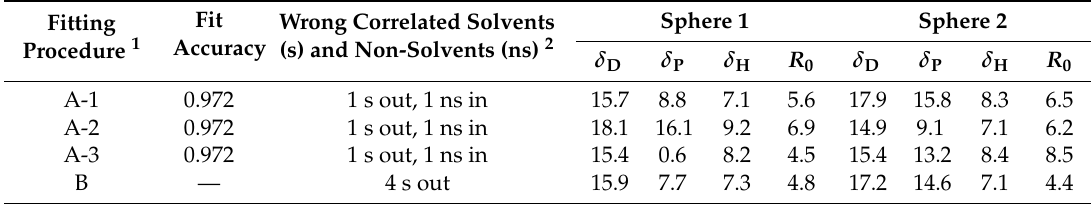
Table 1. Comparison of software fitting and proposed fitting